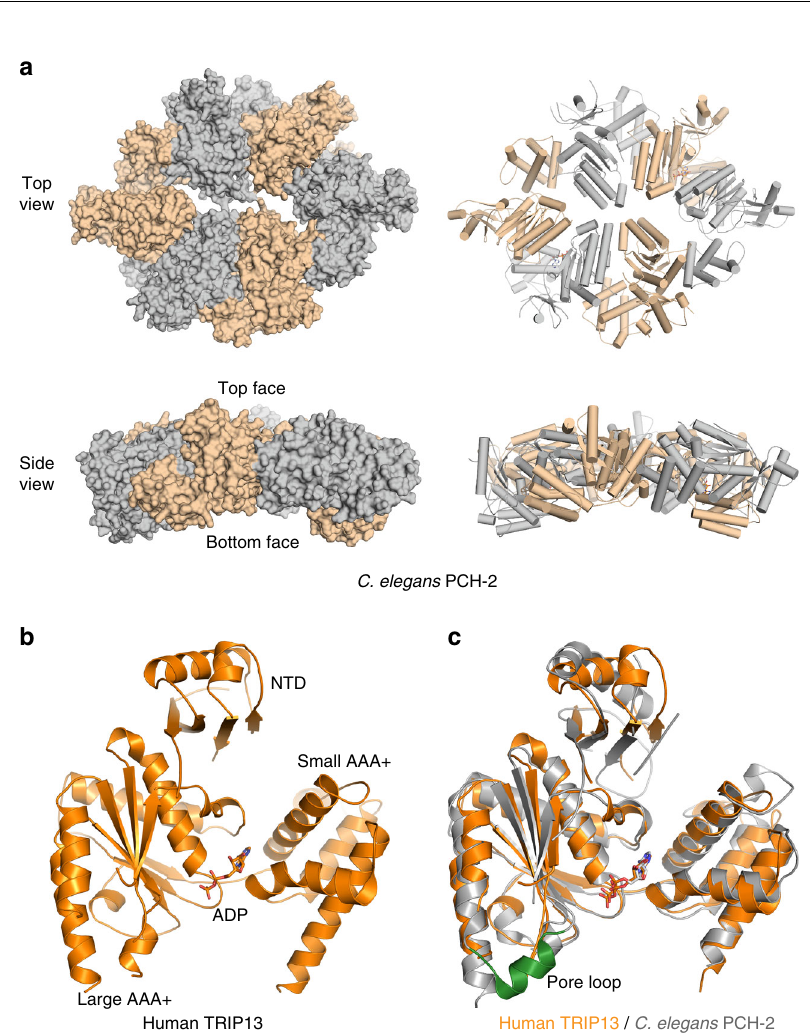
Fig. 3 Crystal structure of human TRIP13 in its ADP-bound state. a Surface and ribbon diagrams of C. elegans PCH-2 (PDB ID: 4XGU) in top and side views. Neighboring protomers are shown in different colors. b Ribbon diagram of the crystal structure of human TRIP13, with the bound ADP shown in sticks. c Overlay of the ribbon diagrams of the structures of human TRIP13 (orange) and the ADP-bound protomer of C. elegans PCH-2 (gray; except the pore loop, which is colored green), with the bound ADP molecules shown in